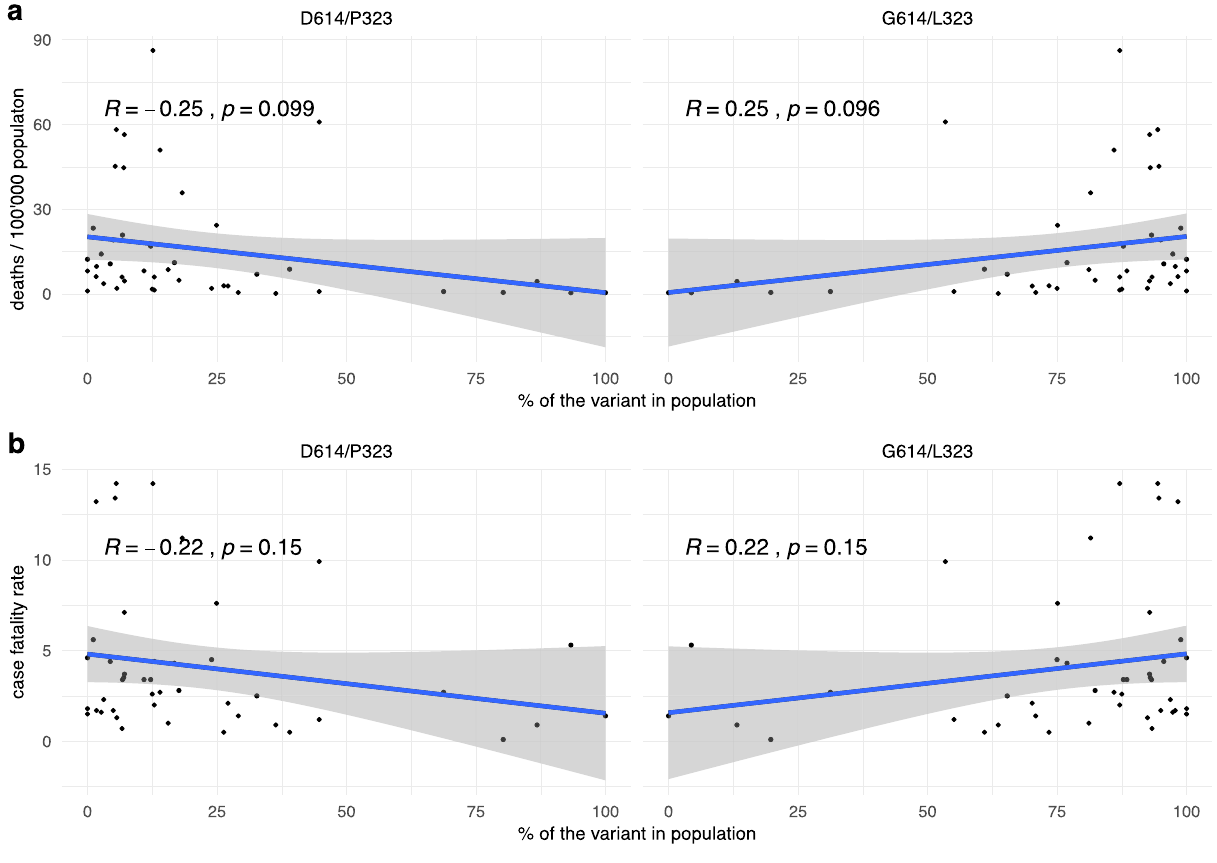
Figure 6. SARS-CoV-2 variants: mortality, case fatality rate, and patient status. Relationship between the percentage of the two main SARS-CoV-2 variants (D614/P323 and G614/L323) in different countries and ( a ) number of deaths per 100 000 population and ( b ) case fatality rate in the respective countries. Numbers of deaths per 100 000 population and case fatality rates were taken from the Johns Hopkins Coronavirus Resource Center (coronavirus.jhu.edu/data/mortality) at 4th of August